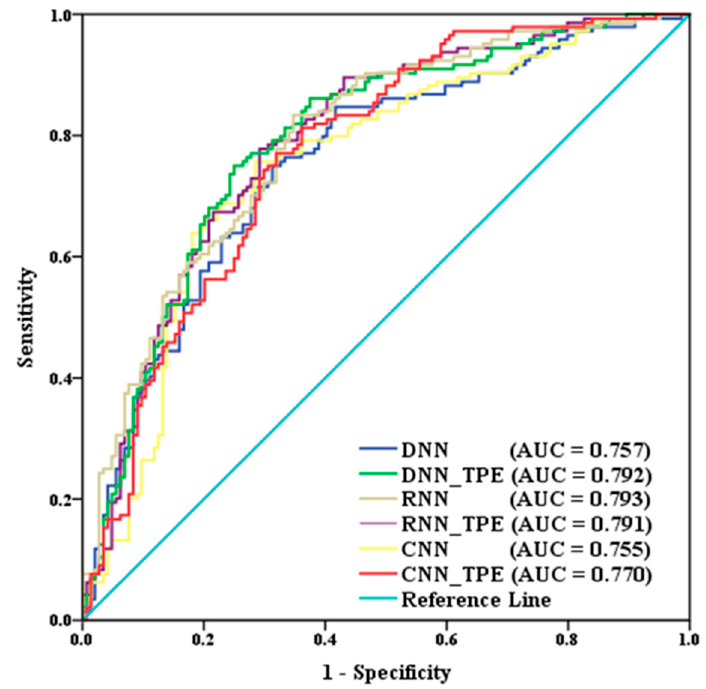
Figure 13. The ROC curves of the neural network models.